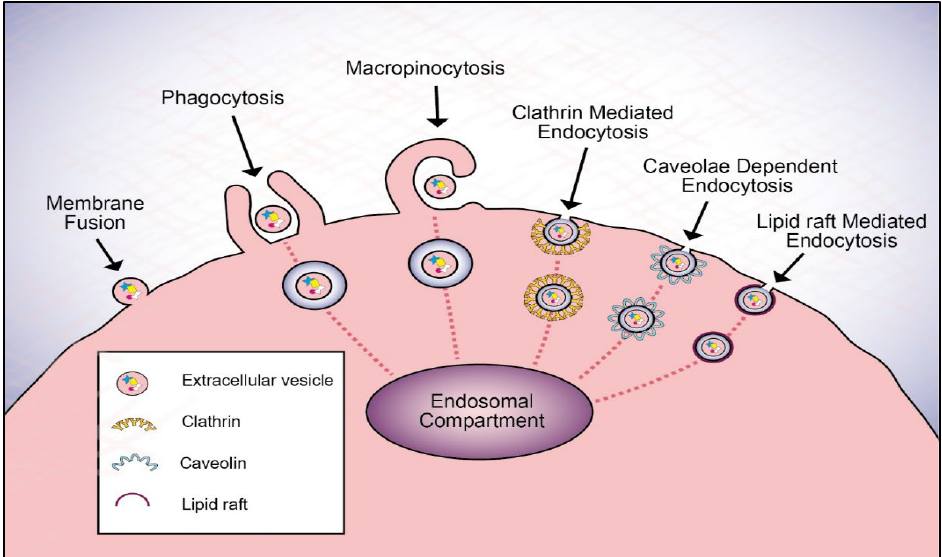
Figure 1. Extracellular vesicle (EV) internalization pathways into recipient cells. Exogenous EVs have been shown to be internalized by cells via multiple endocytic pathways depending on cell type. These pathways include the following: 1-phagocytosis, a process used by professional